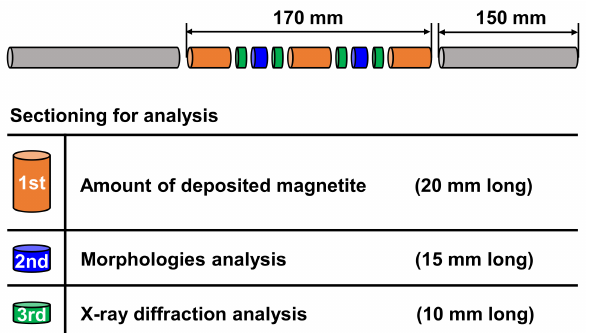
Figure 3. Sections of an Alloy 690TT tube used as specimens for analysis after the magnetite deposition